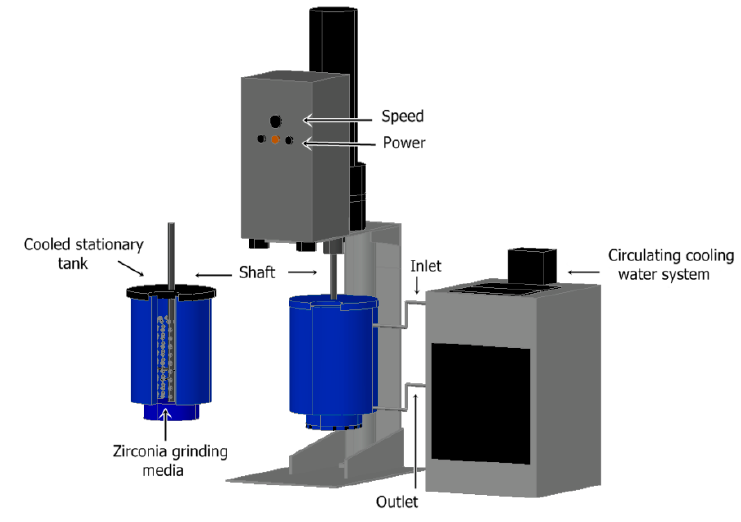
Figure 2. Schematic diagram of the experimental setup used for grinding.